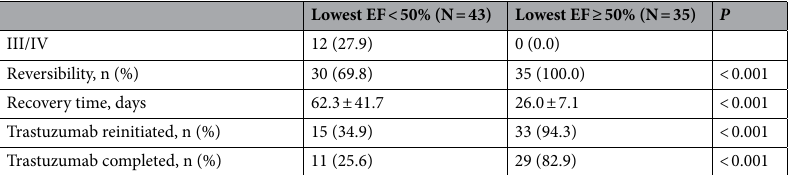
Table 3. Subgroup analysis of patients with cardiotoxicity based on lowest ejection fraction. BMI Body Mass Index, HER2 Human epidermal growth factor receptor 2, A Adenin, G Guanine, T Tumor, N Node, ER Estrogen Receptors, PR Progesterone Receptors, ISH In situ Hybridization, IHC Immunohistochemistry, EF Ejection Fraction, NYHA New York Heart Association, P value was calculated with one-way analysis of variance